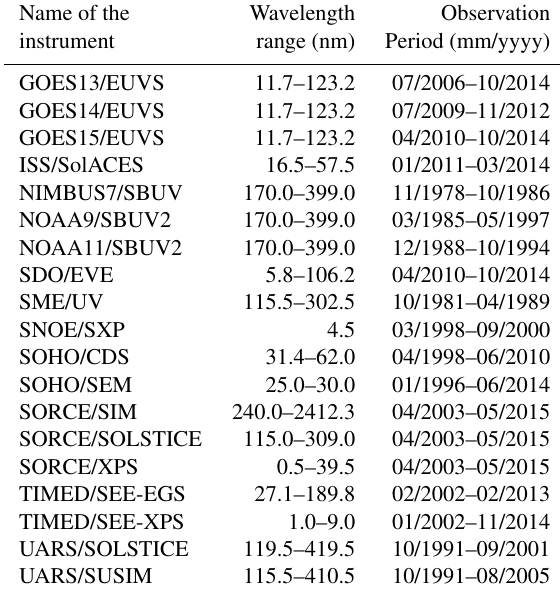
Table 1. SSI datasets used for the SOLID composite. The first col- umn gives the instrument, the second column the spectral band, and the third column the temporal coverage of the